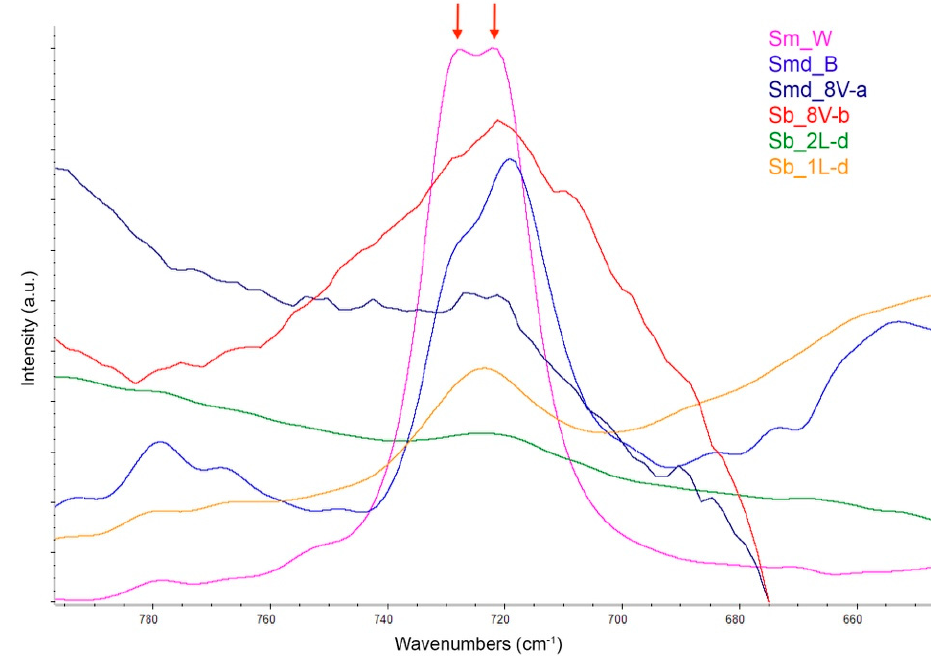
Figure 9. Characteristic peaks of shellac wax.